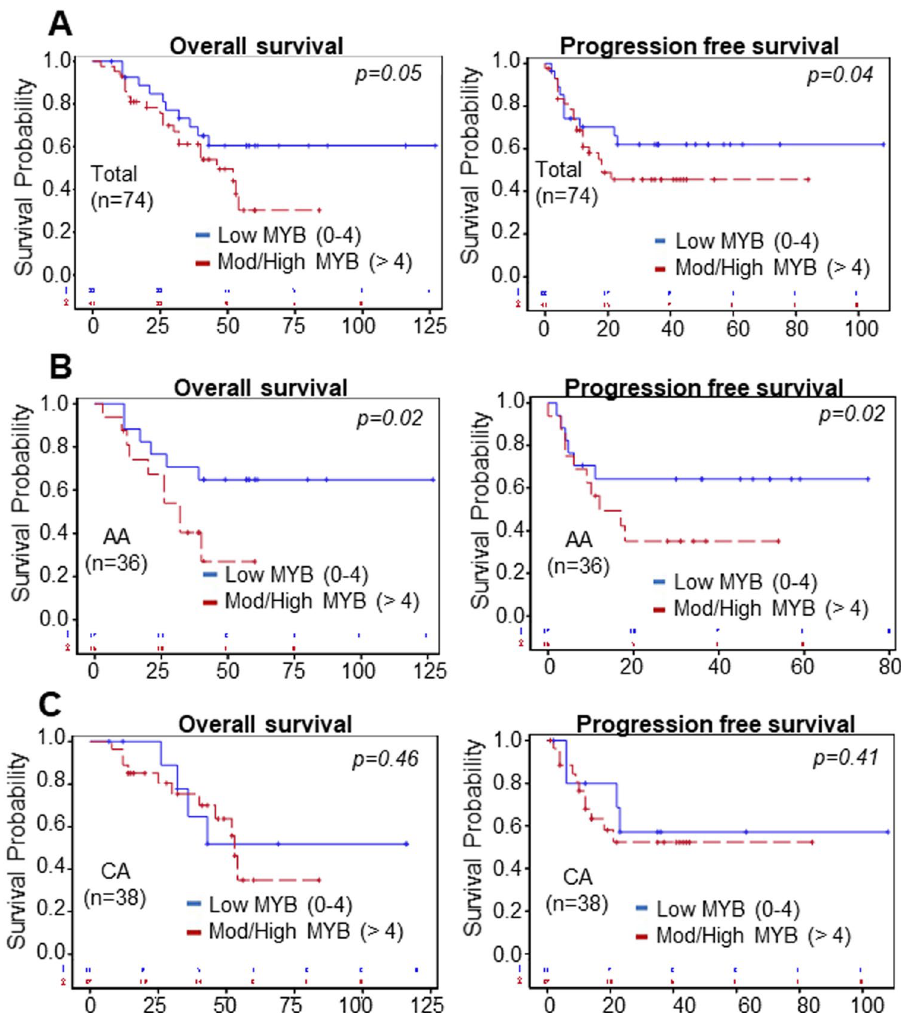
Figure 3. Association between MYB expression and the survival of ovarian cancer patients. ( A ) Kaplan–Meier survival analysis for the association of MYB with the overall survival (left panel) and progression-free survival (right panel) of ovarian cancer patients (n = 74). A significant association (p = 0.04) of MYB was recorded with poor progression-free survival in ovarian cancer patients when compared between low (≤ 4) versus moderate to high ( ˃ 4) MYB expressing patients. A clear trend of MYB association with overall survival was also recorded (p = 0.05). ( B , C ) Association between MYB expression and the survival of OC patients with AA and CA racial background. AA women with OC showed poor overall (p = 0.02 vs. p = 0.46) and progression-free survival (p = 0.02 vs. p = 0.41) than the patients of CA